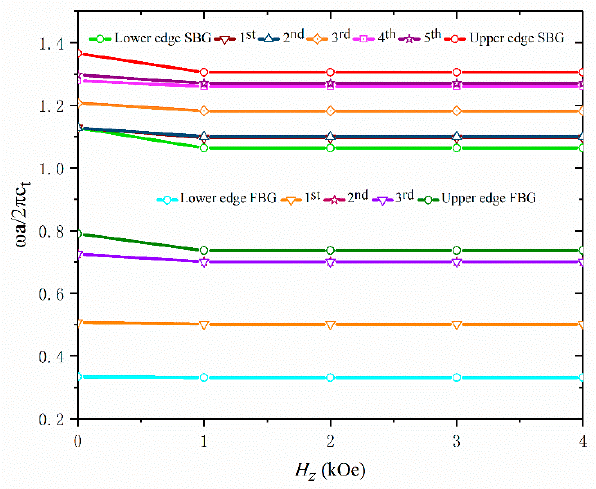
Figure 14. Variation in defect band frequency ( Z mode) as a function of the magnetic field with given σ z = 0 MPa.